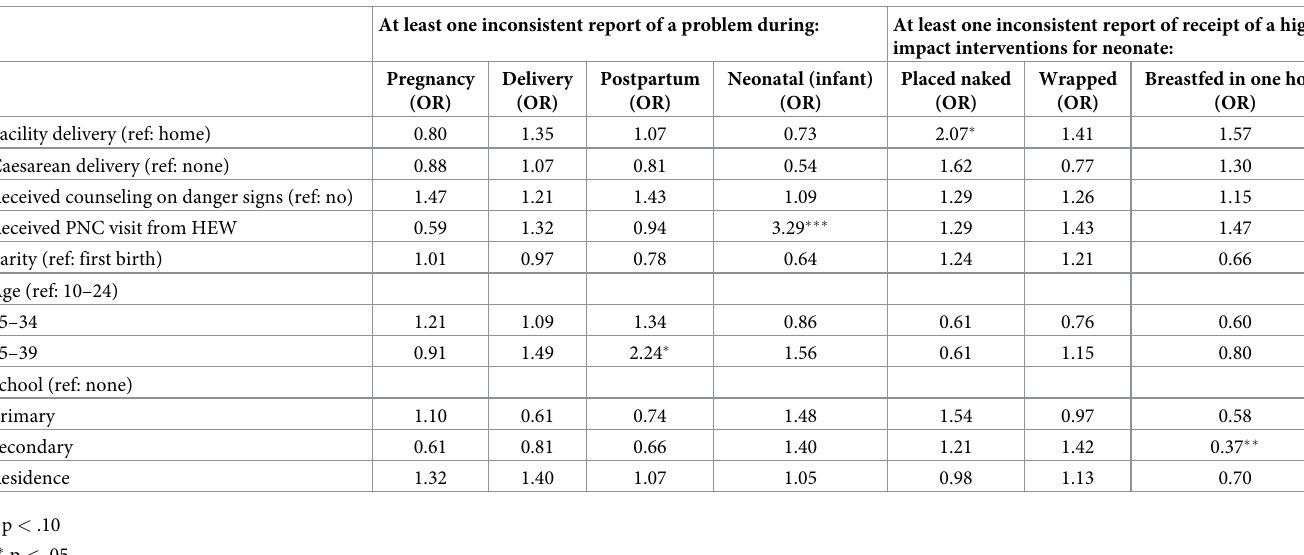
Table 9. Adjusted odds-ratio (OR) estimates from logistic regression model showing association of maternal characteristics and reporting discordant responses for complications/illness and receipt of interventions. At least one inconsistent report of a problem